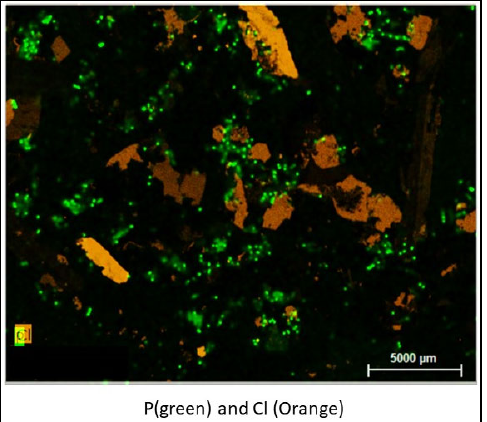
Figure 3. P (green) and Cl (orange) μ‐ EDXRF maps.